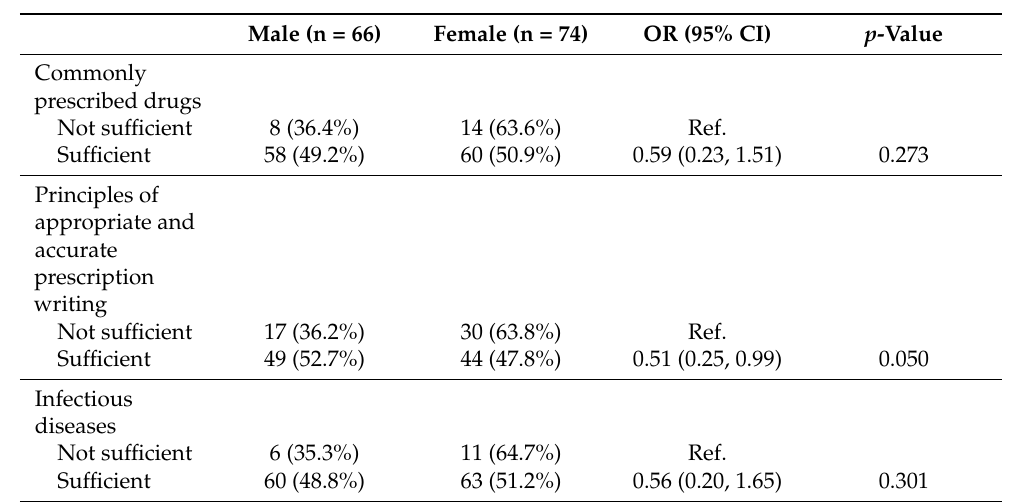
Table 2. Frequency and odds of gender in the formal education and training sufficiency and confi- dence in pharmacology.